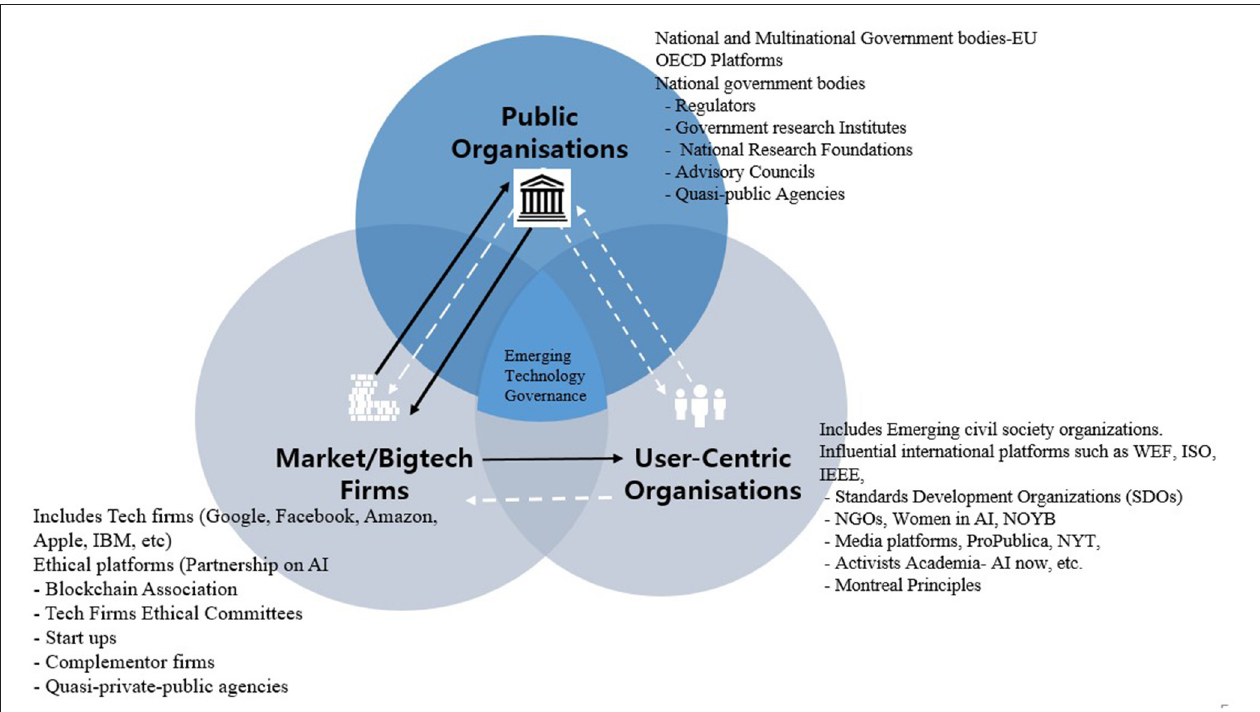
FIGURE 4 | Emerging technology governance platforms in the public sector.